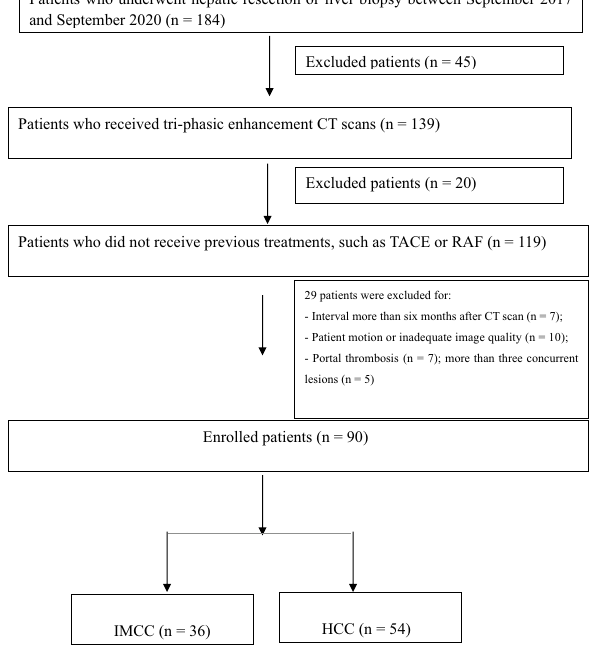
Figure 1. Flow diagram detailing the inclusion and exclusion criteria for the